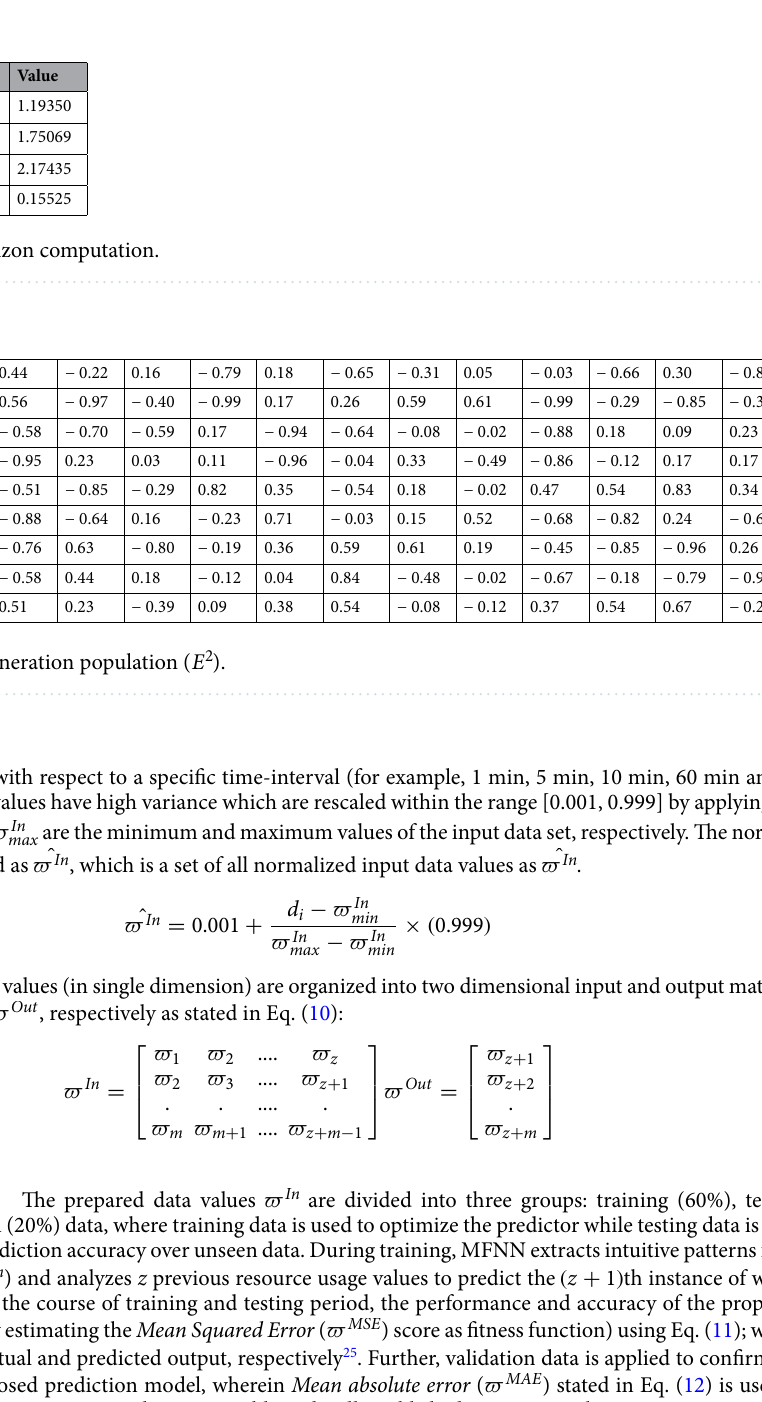
1 Gbest ) after Heuristic Crossover.